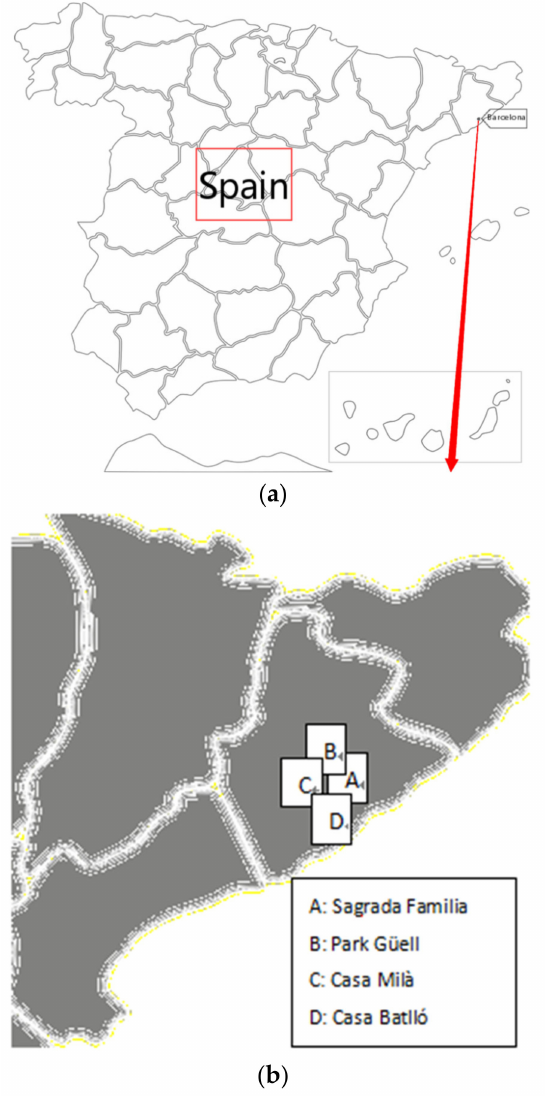
Figure 1. ( a ) Barcelona on the map of Spain. Source: authors’ own preparation. ( b ) Map of Barcelona and its top cultural locations. Source: own